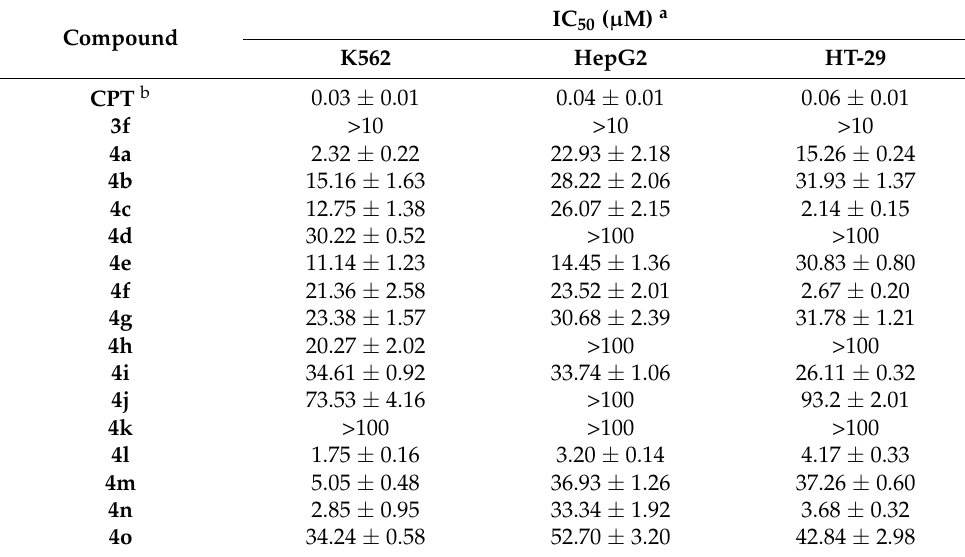
Table 1. In vitro cytotoxic effect of isatin